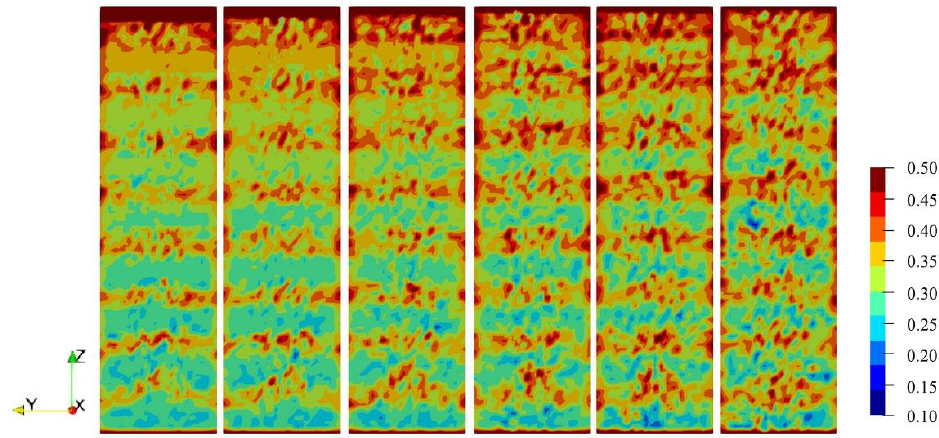
Figure 19. Void fraction distribution of stock columns with different particle size ratios.